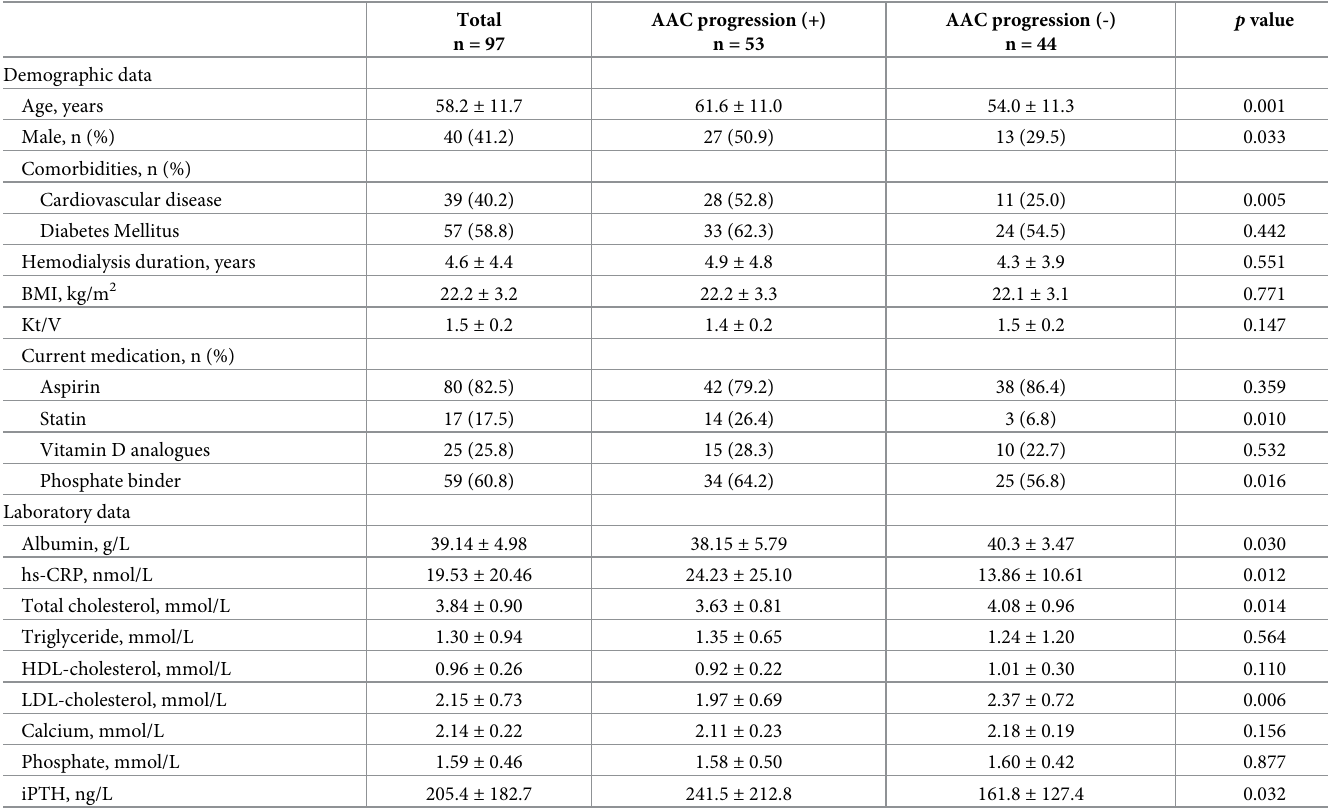
Table 1. Clinical characteristics and laboratory results according to AAC